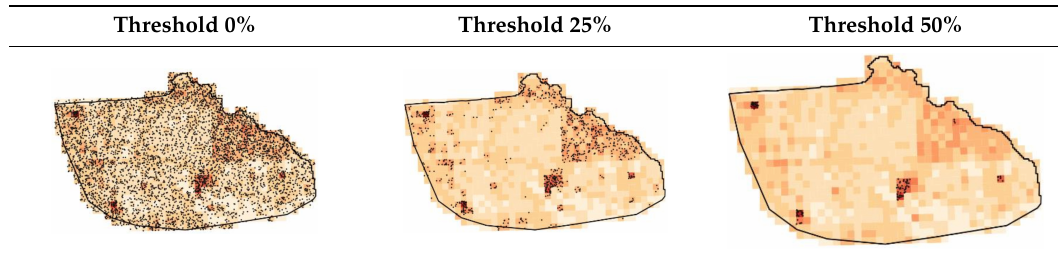
Table 3. Comparison of the number of generated points depending on the value of the threshold coe ffi cient.